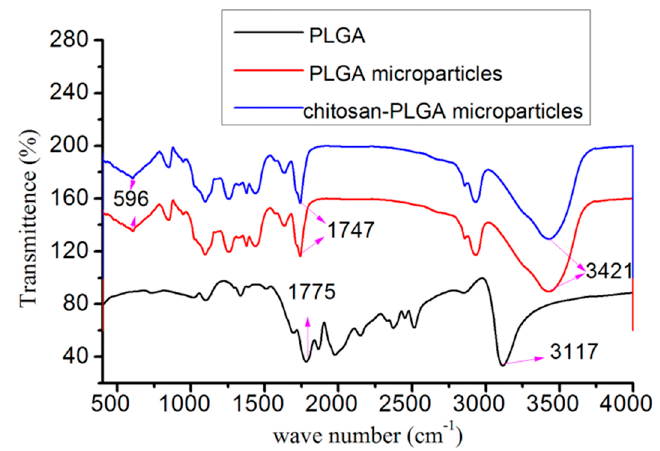
Figure 4. Fourier transform infrared (FTIR) spectra of PLGA, PLGA microparticles, and chitosan–PLGA microparticles in the range 400–4000 cm − 1 .